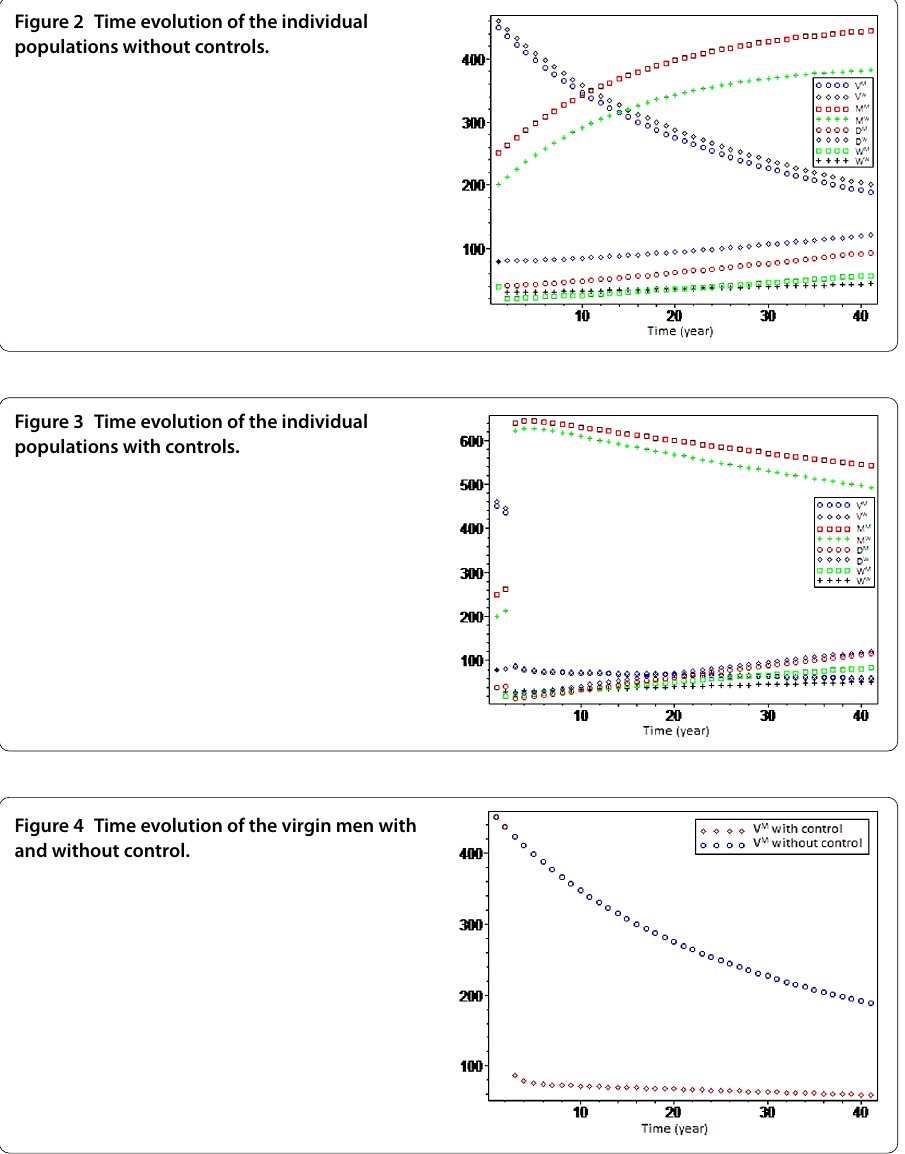
Figure 2 Time evolution of the individual populations without controls.